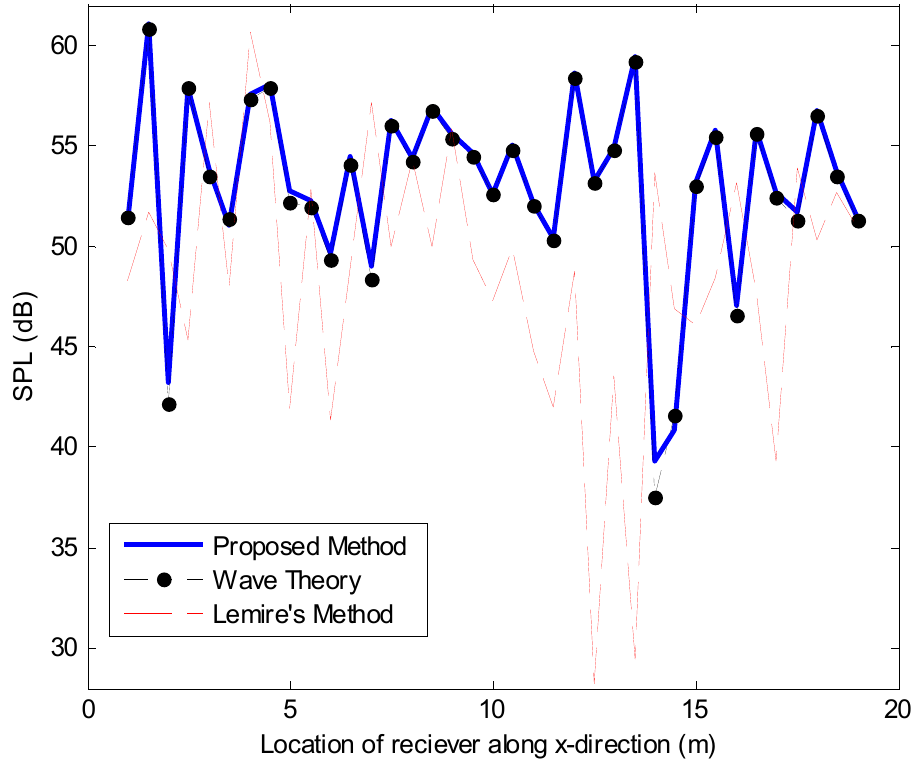
Figure 5. Comparison of predictions on sound pressure level (SPL) at a frequency of 1000 Hz vs. the receiver location along the x -direction. The source is located at (6 m, 0 m, 1 m) and the receiver is located at ( x r , 50 m, 1 m) with x r moving from 1 m to 19 m. The solid line represents the results with the proposed method, the solid circles are those with the wave theory that is considered as a benchmark, and the dash line is the result with the method of Lemire and Nicolas (Lemire’s method).